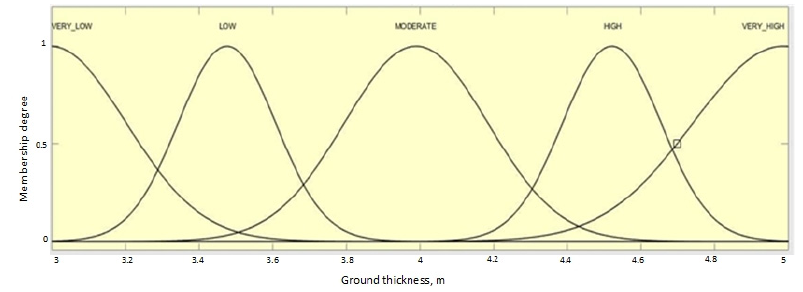
Figure 7. The MFs of ground thickness.